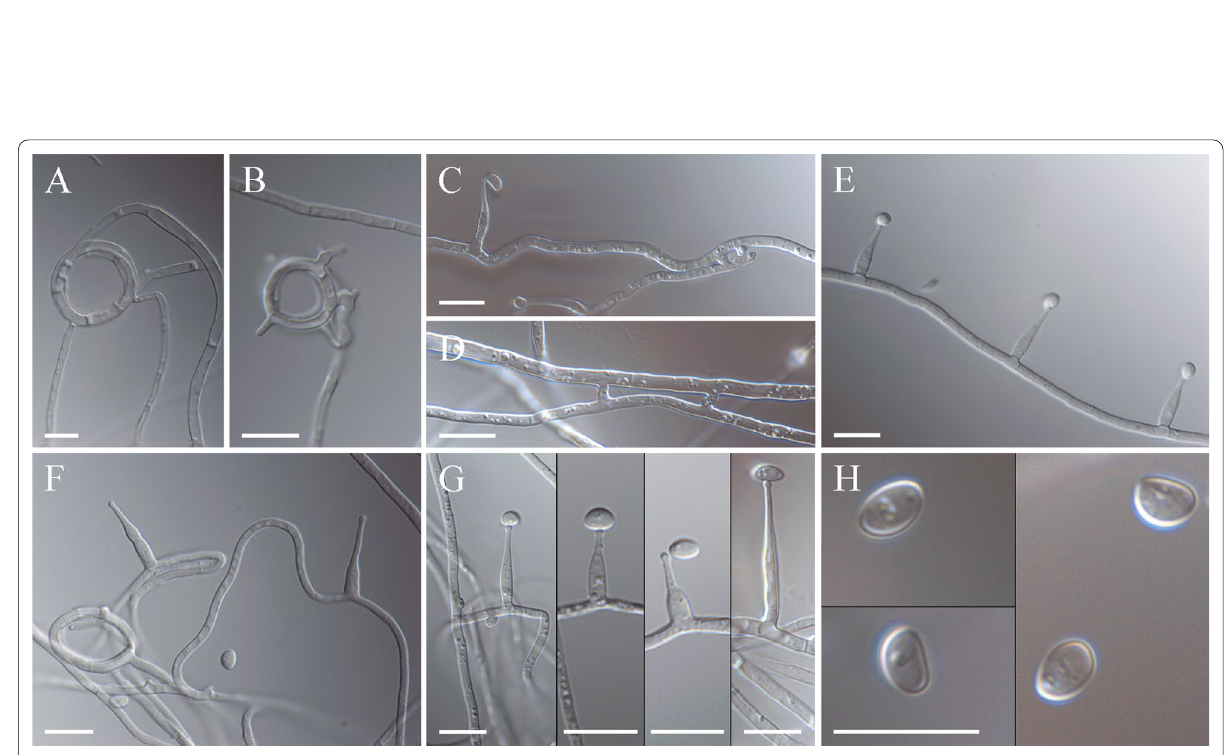
Fig. 6 Micrographs of Epichloë scottii on potato dextrose agar. a , b Fungal growth and formation of coiling hyphae. c, d Hyphal anastomosis. e developing hyphae bearing conidiogenous cells and conidia. f Growing hyphae forming ring, conidiogenous cells arising from hyphae and conidia, g details of conidiogenous cells bearing conidia. h conidia. Bars 10 =